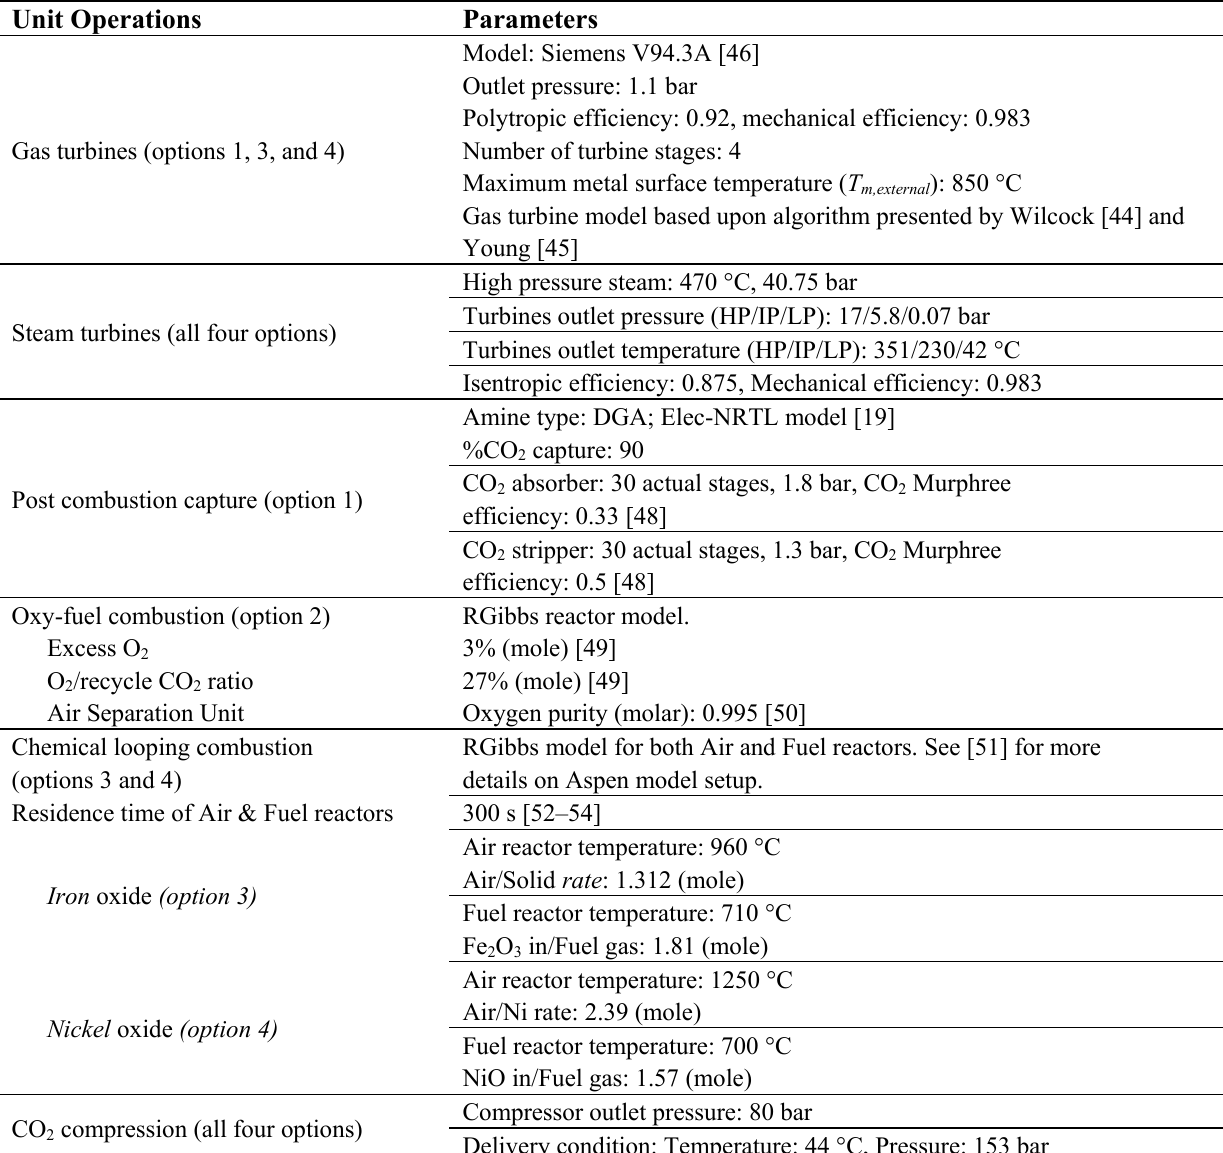
Table 5. Process design specifications of the power